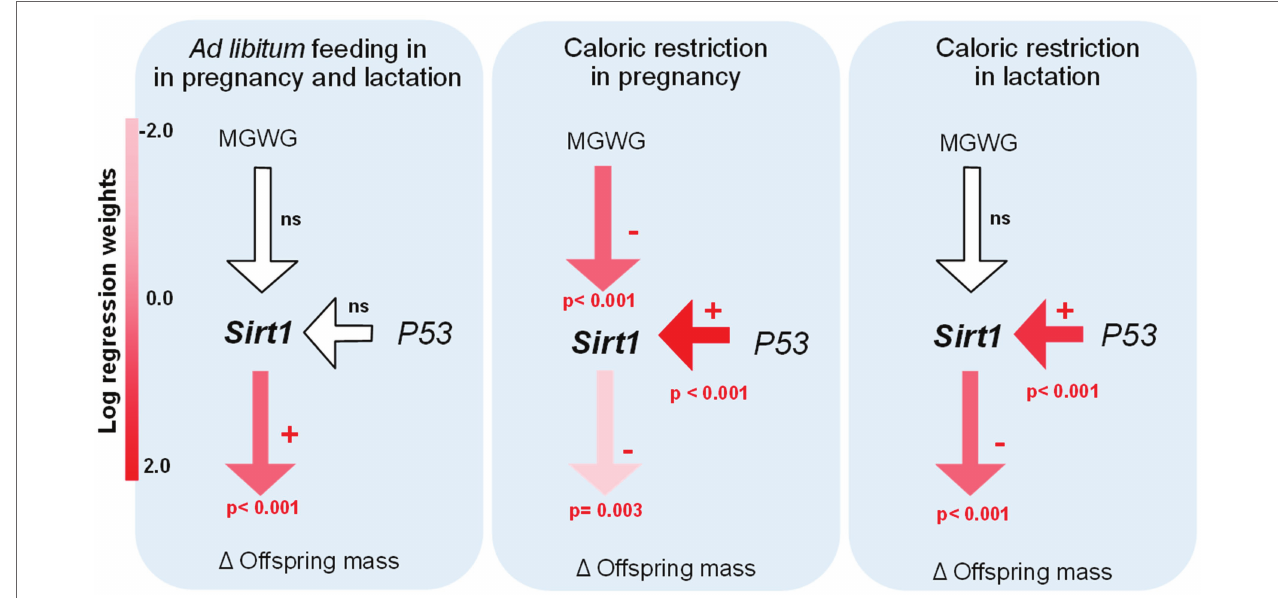
FIGURE 10 | Evaluation of causal models in adult male BALB/c mice, considering all treatments of perinatal and adult food availability. Examination of the relationships between key genes in the liver (S irt1 and P53, respect to B2m ), body mass changes in adult acclimation (caloric restriction), and maternal gestational weight gain. The significance of each parameter is presented only in significant cases, and the magnitude of regression weights is represented by a color